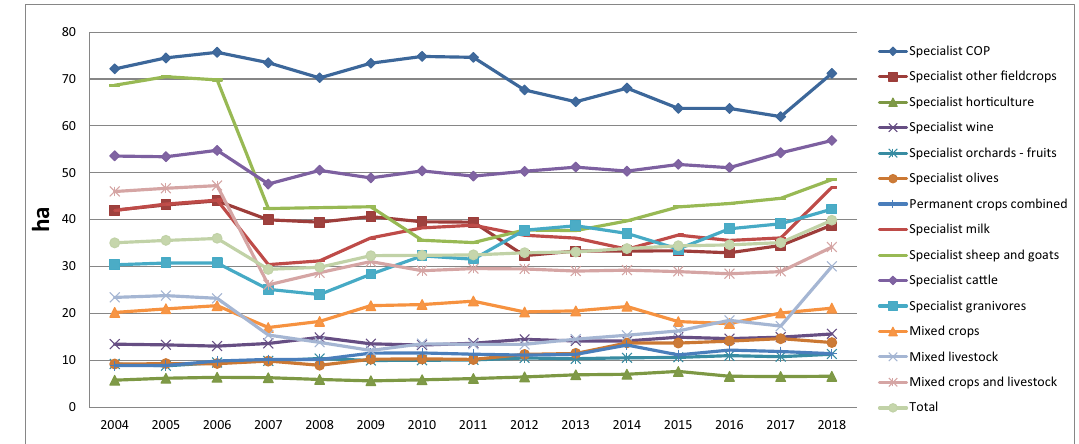
Figure 2: Total Utilised Agricultural Area ( ha ) , per farm, for several farm types, for the period 2004 –